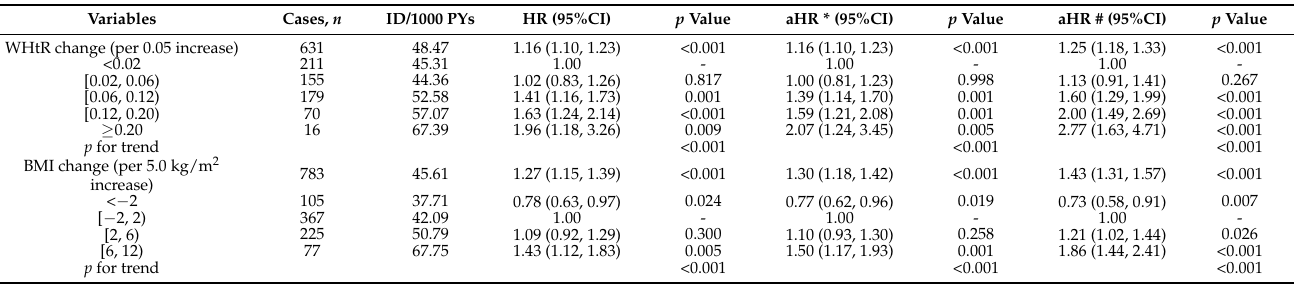
Table 3. Associations between changes of WHtR and BMI from baseline to follow-up and the risk of incident